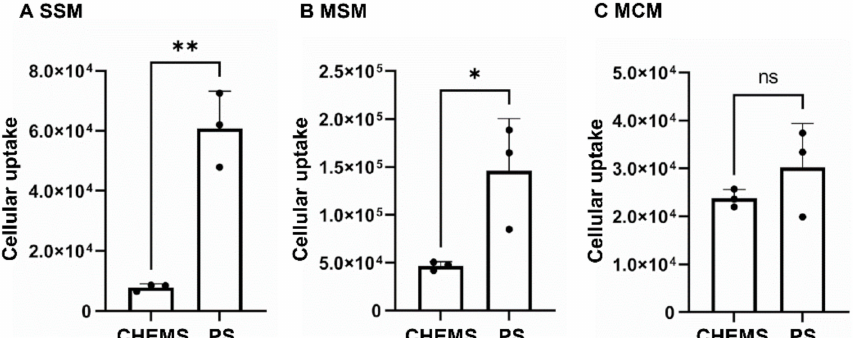
Figure 1. Uptake of anionic liposomes with CHEMS or PS by macrophages. Cell suspension was isolated from mice LNs and then incubated with each DiD-labeled liposome at 50 µ M for 2 h. After washing free liposomes, DiD fluorescence in ( A ) SSM, ( B ) MSM, and ( C ) MCM were analyzed by